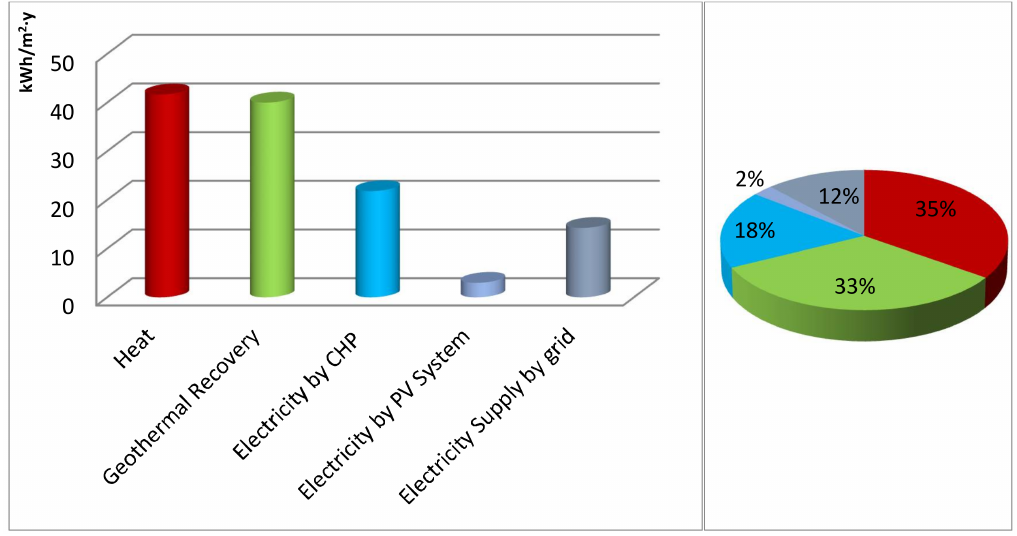
Figure 18. Primary energy renewable balance at LUCIA